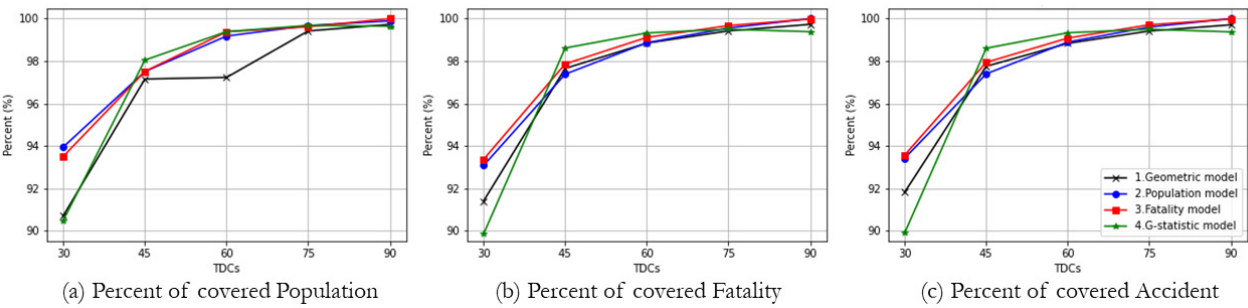
Figure 7. ACLP solutions from different weighted objectives by potential demands. ( a ) Percent of covered population; ( b ) Percent of covered fatality; ( c ) Percent of covered accident.